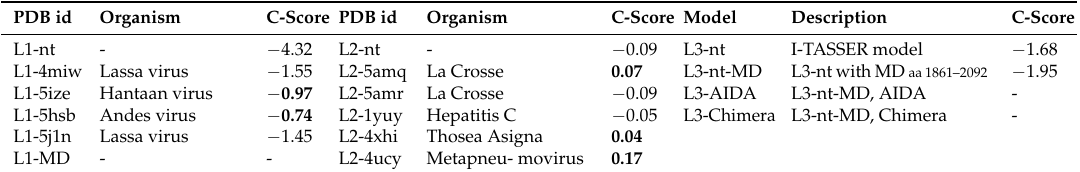
Table 1. Structural models considered for the L1, L2, and L3 templates provided to I-TASSER [19]. C-score values in bold are the best for domains L1 and L2.